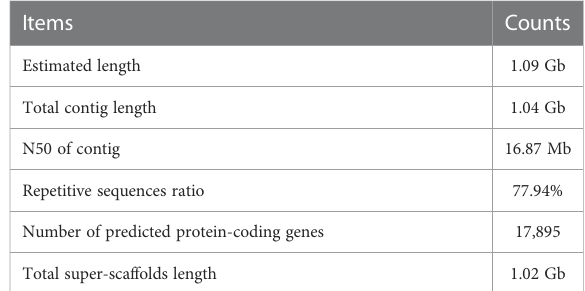
TABLE 1 Characteristics of G03 genome